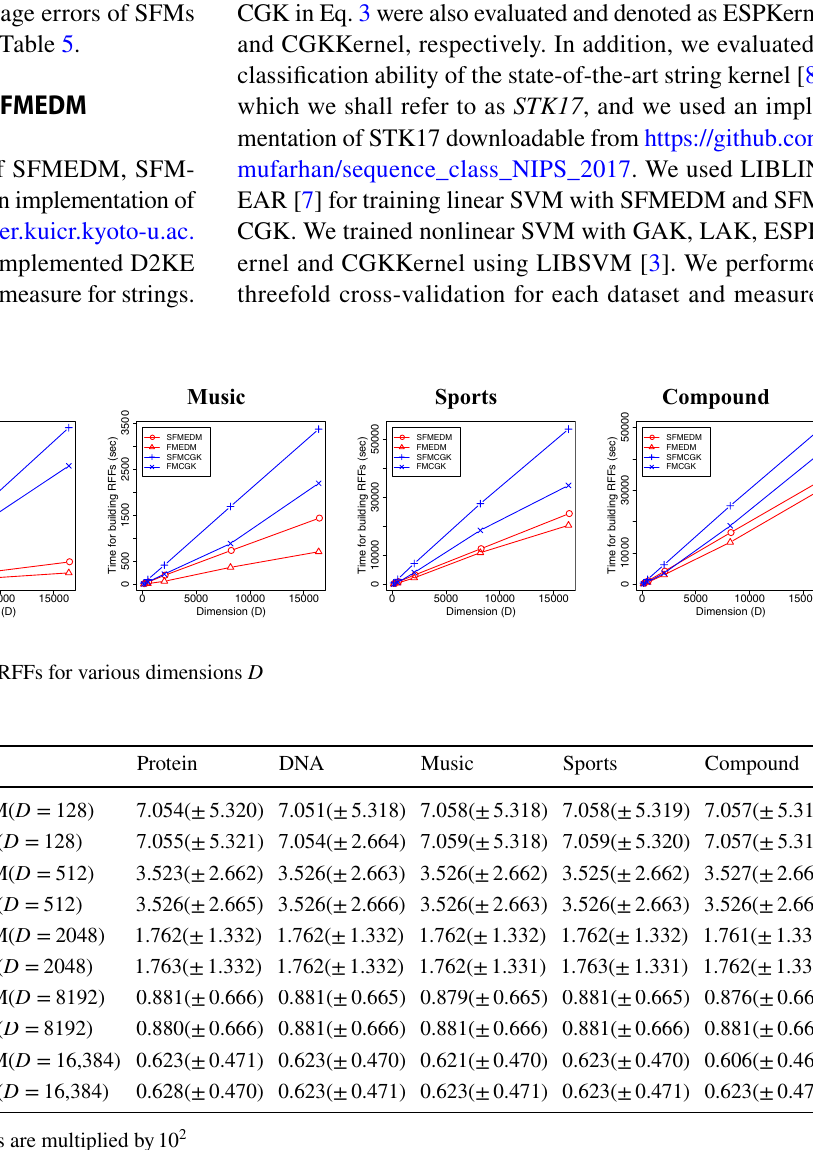
All values are multiplied by